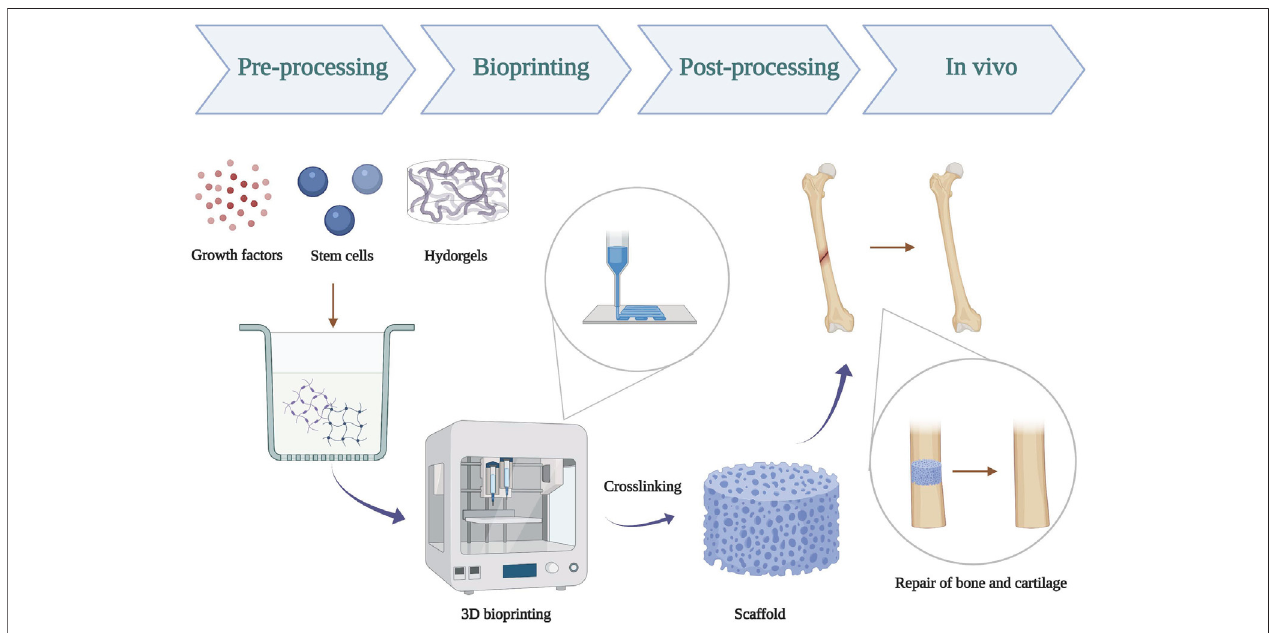
FIGURE 1| Schematic illustration of 3D bioprinting ofhydrogels scaffold for repair of bone and cartilage defect. Pre-processing: prepare a mixture using hydrogel, stem cells, and growth factors; bioprinting: successful 3D bioprinting of biomaterials with physiological cell density in a designed way; post-processing: crosslinking of bioprinted constructs by